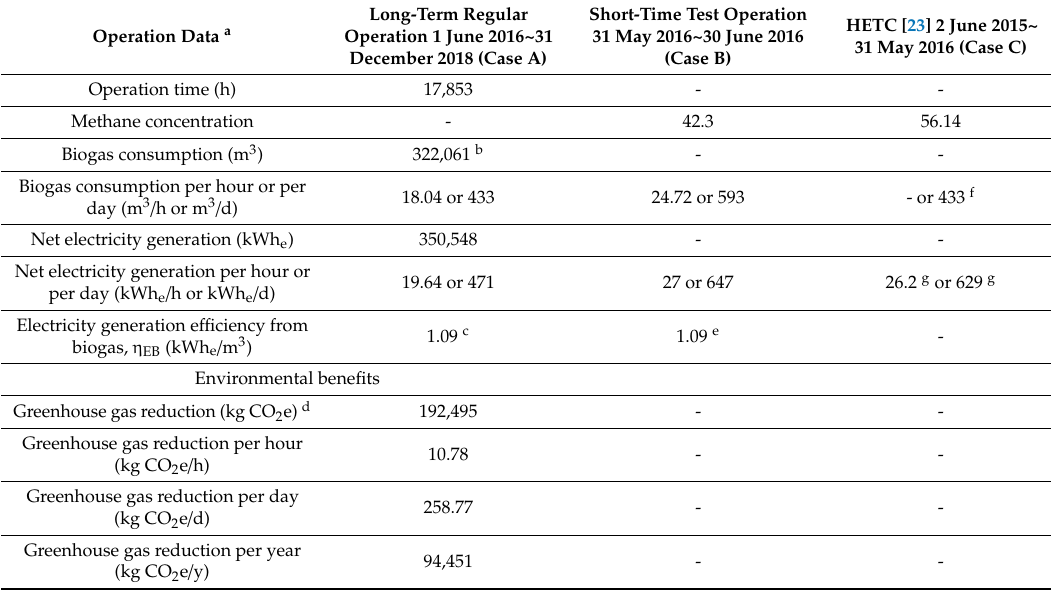
Table 4. Benefits of electricity generation and greenhouse gas reduction based on the emission factors of greenhouse gas from electricity generation in Taiwan for one 30 kW MGT electricity generator under regular operation from 1 June 2016 to 31 December